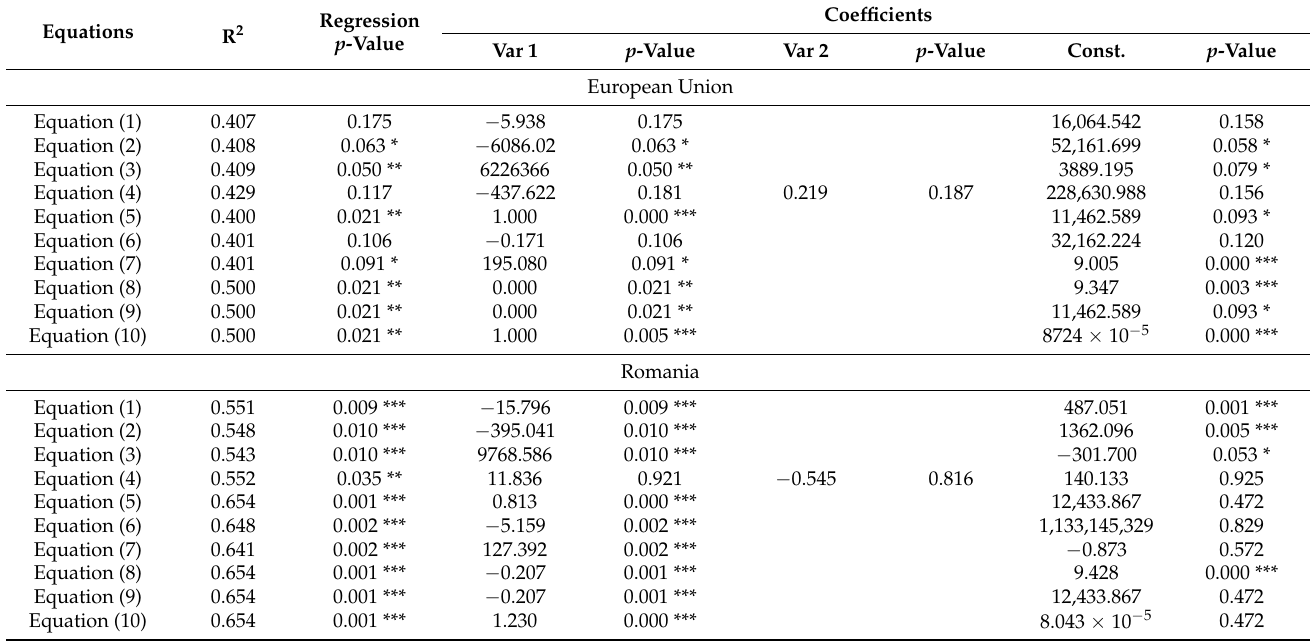
Table A1. Estimation of parameters of linear and nonlinear equations for GDP and FEC (1995–2020).